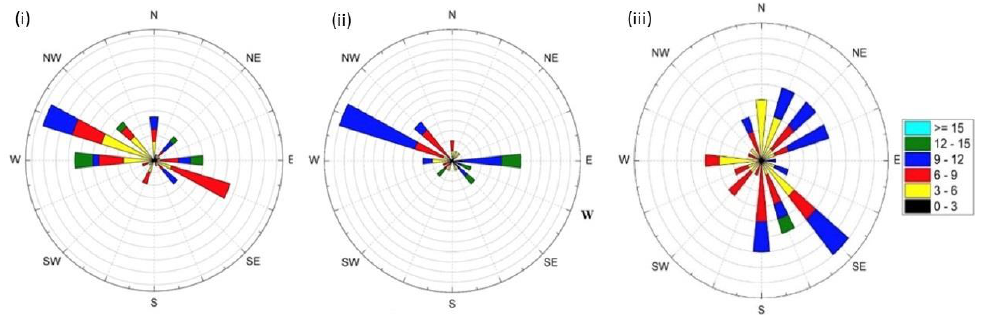
Figure 5. Rose diagrams of wind over ( i ) Sabah, Malaysia, ( ii ) Batangas, Philippines, from 12-14 January 2020 and ( iii ) Manila, Philippines, from 12-17 January 2020 showing dominant wind south-east and north-east directions. The emissions from the Taal volcano may be dispersed in all the directions in the proximity of the Taal volcano since the wind shows all the directions, with the dominant wind in the